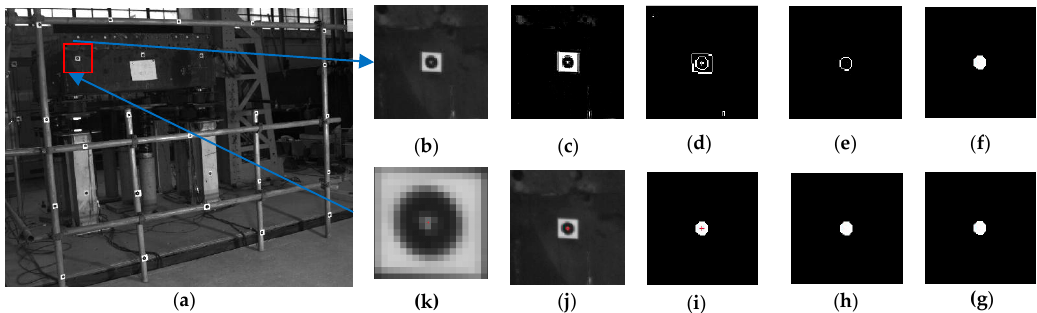
Figure 6. Elliptical-shaped target detecting and tracking of tri-camera image sequences, ( a ) original image from the image sequences, ( b ) an image block extracted from the original image a, ( c ) enhanced image block, ( d ) contour features after morphological edge detection, ( e ) the image block eliminated the lower and higher values of edge features, ( f ) the image block after filling morphological filling and dilation using the diameter attribute, ( g ) the image block after eliminating the lower and higher values by area attribute, ( h ) the image block after eliminating the features using the degree of circularity of threshold value 0.9, ( i , j ) central coordinates of the image block, and ( k ) the five-time amplification effect of the tracking target and the corresponding central coordinates.